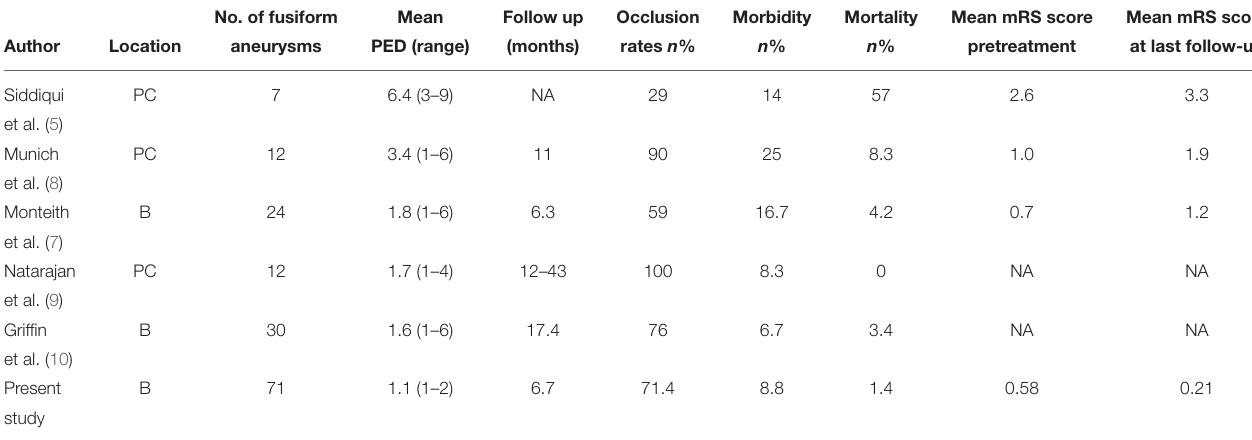
TABLE 6 | Flow diversion (PEDs) for treatment of fusiform